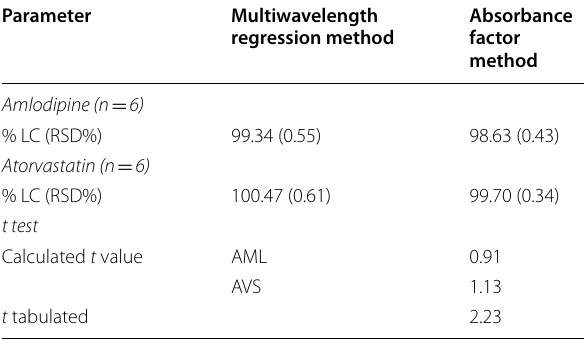
Table 9 Analysis of the commercial product and their